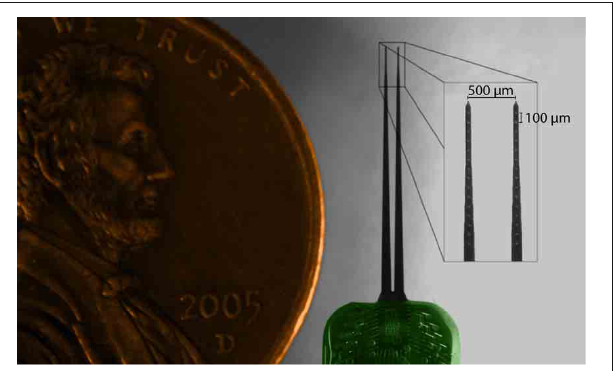
FIGURE 1 | Microscope image of acutely-implanted Michigan electrode array (NeuroNexus Technologies, Ann Arbor, MI) consisting of